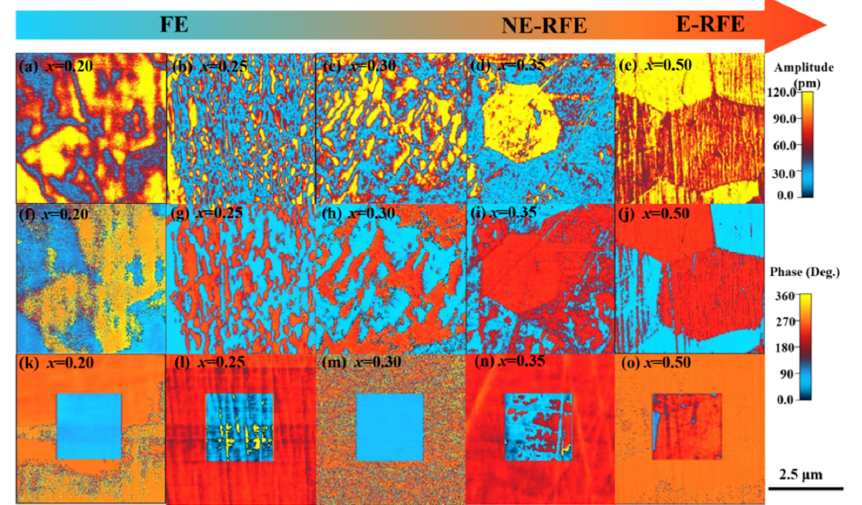
Figure 11. PFM scanning image of (1- x )BiFeO 3 –( x )BaTiO 3 . Out-of-plan amplitude; ( a ) x = 0.20, ( b ) x = 0.25, ( c ) x = 0.30, ( d ) x = 0.35, and ( e ) x = 0.50. Out-of-plan phase; ( f ) x = 0.20, ( g ) x = 0.25, ( h ) x = 0.30, ( i ) x = 0.35, and ( j ) x = 0.50. The “box-in-box” DC writing under the ± 10 V; ( k ) x = 0.20, ( l ) x = 0.25, ( m ) x = 0.30, ( n ) x = 0.35, and ( o ) x = 0.50. Reprinted with the permission of [93]. Copyright © 2018